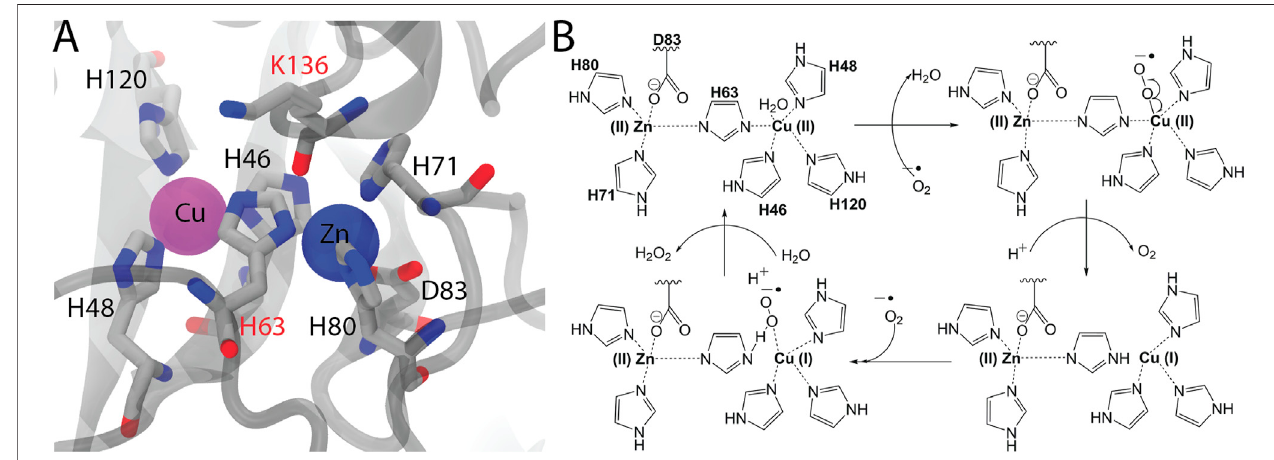
FIGURE 2 | (A) The close-up view of the bimetallic center and surrounding amino acids that are located in the fi rst coordination shell ( < 5 Å) were visualized in the 2V0A structure (C: cyan, O: red, N: blue). The amino acids that were not linked to any ALS cases were shown by red-labels. (B) Proposed mechanism of the SOD1 reaction wherein Cu-center acts as the catalytic